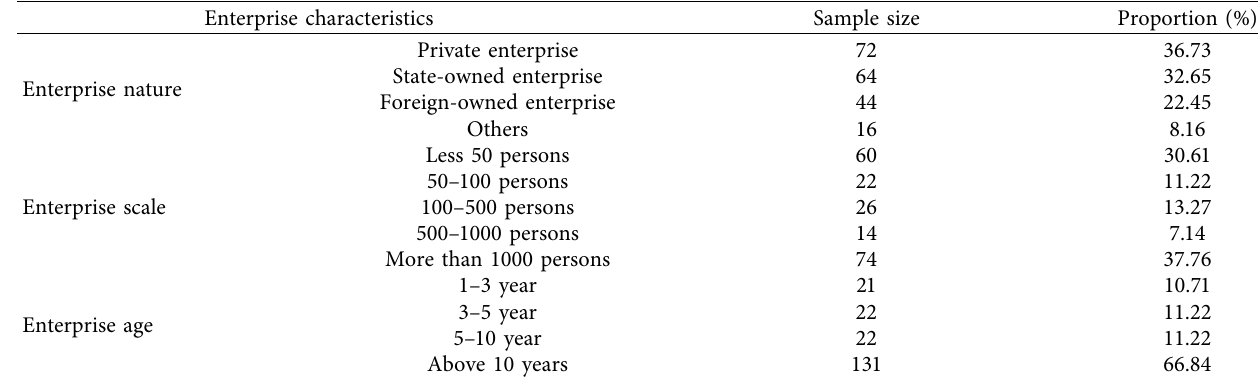
Table 1: Te descriptive statistics of the sample.